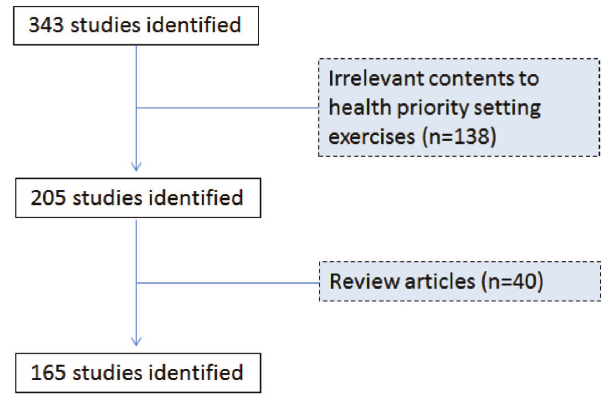
Figure 1. Flowchart of the review on all priority–setting exercises for health research conducted between 2001 to